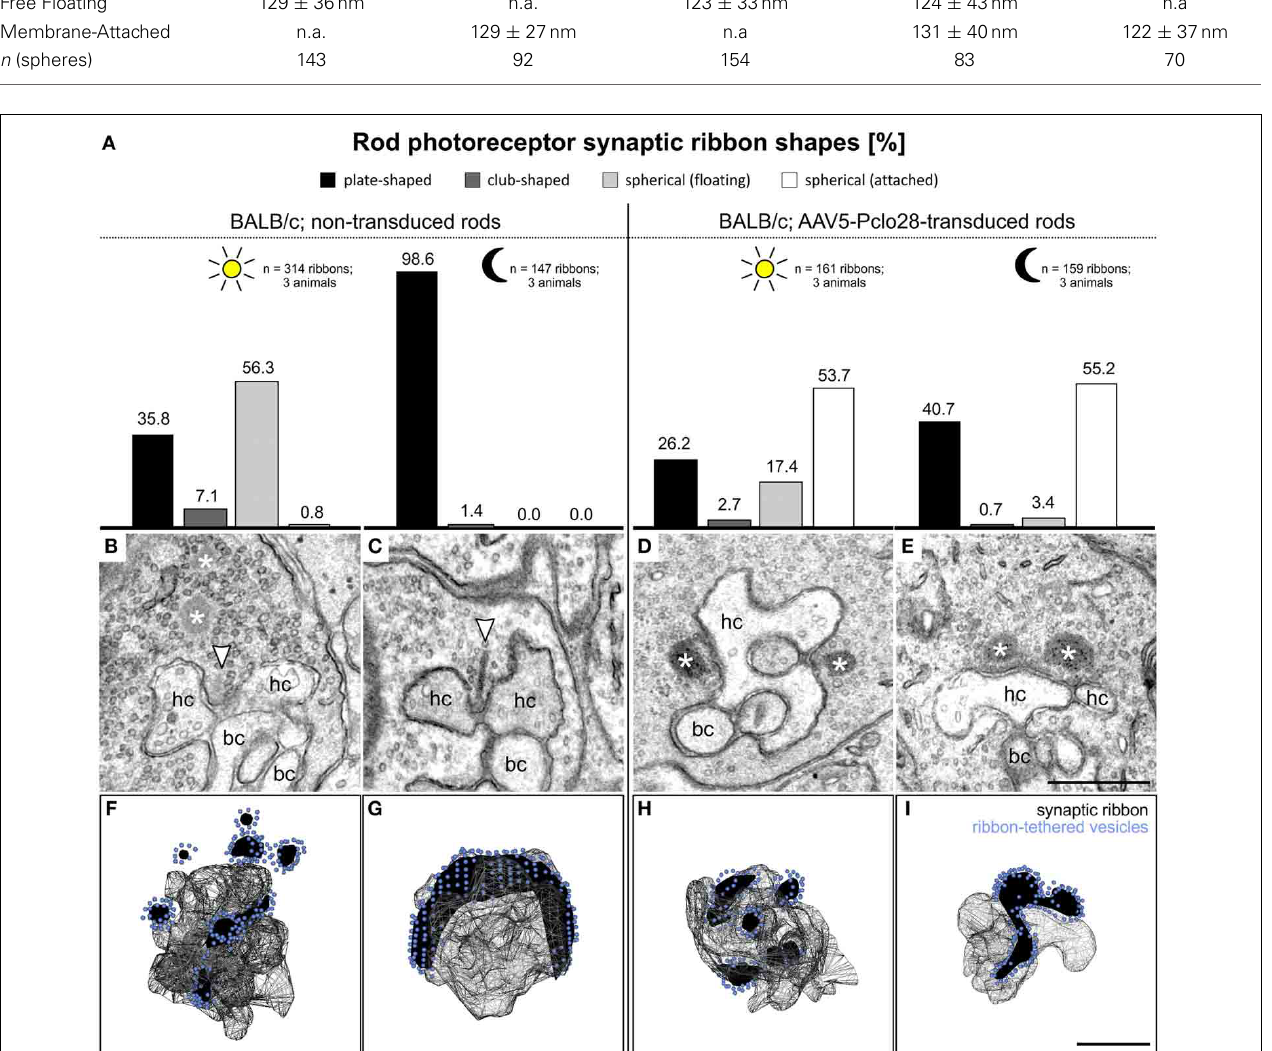
FIGURE 7 | Ultrastructural analysis of rod photoreceptor ribbon synapses in the AAV5-Pclo28-transduced BALB/c retina. (A) Percentages of the four different shapes of ribbon profiles—plate-shaped, club-shaped, floating and membrane-attached spheres—in non-transduced and AAV5-Pclo28-transduced rod photoreceptor terminals of BALB/c mice after 3h light and dark adaptation. (B–E) Representative electron micrographs of rod photoreceptor ribbon synapses in non-transduced 3h light (B) and dark adapted (C) , and in AAV5-Pclo28-transduced 3h light (D) and dark adapted